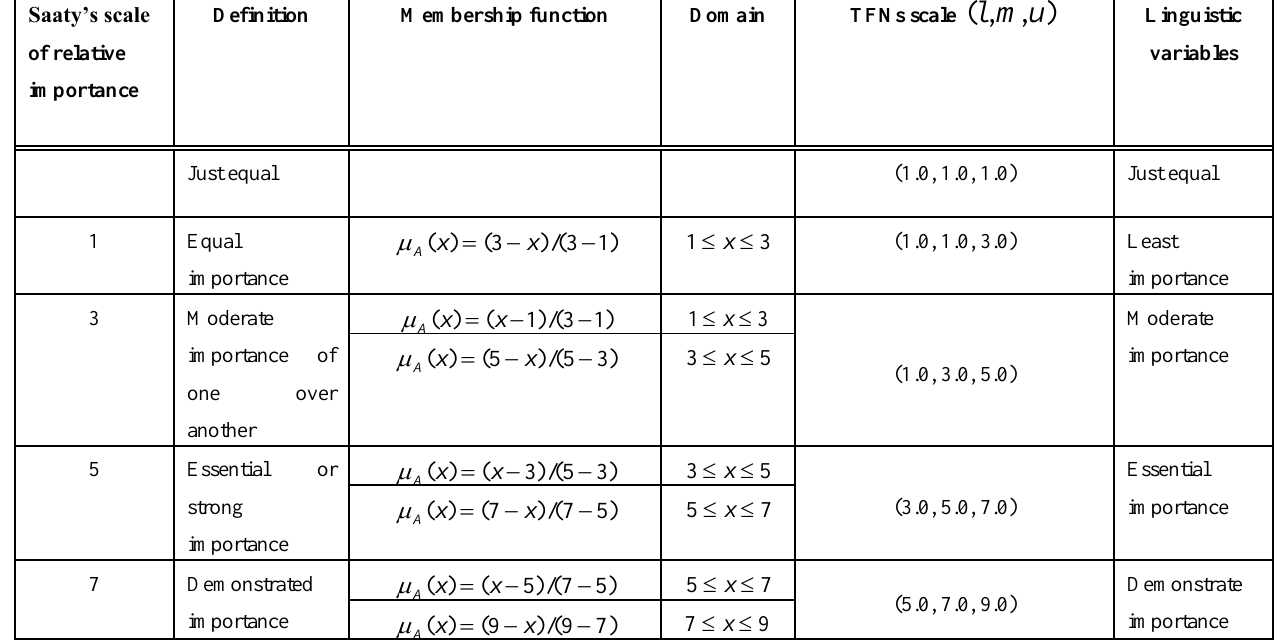
Table 3. Proposed TFNs, linguistic variables and membership